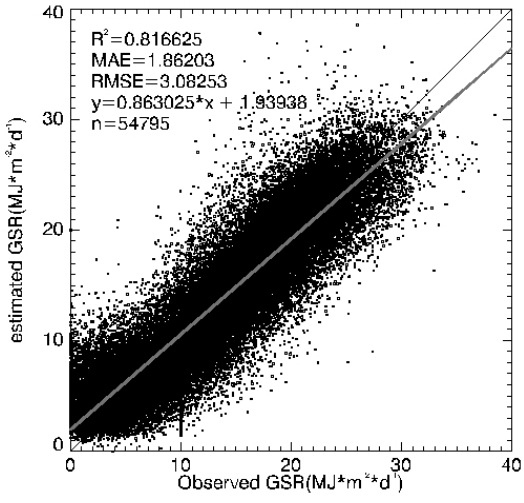
Figure 3. The validation of the estimated global surface radiation (GSR) by station-based